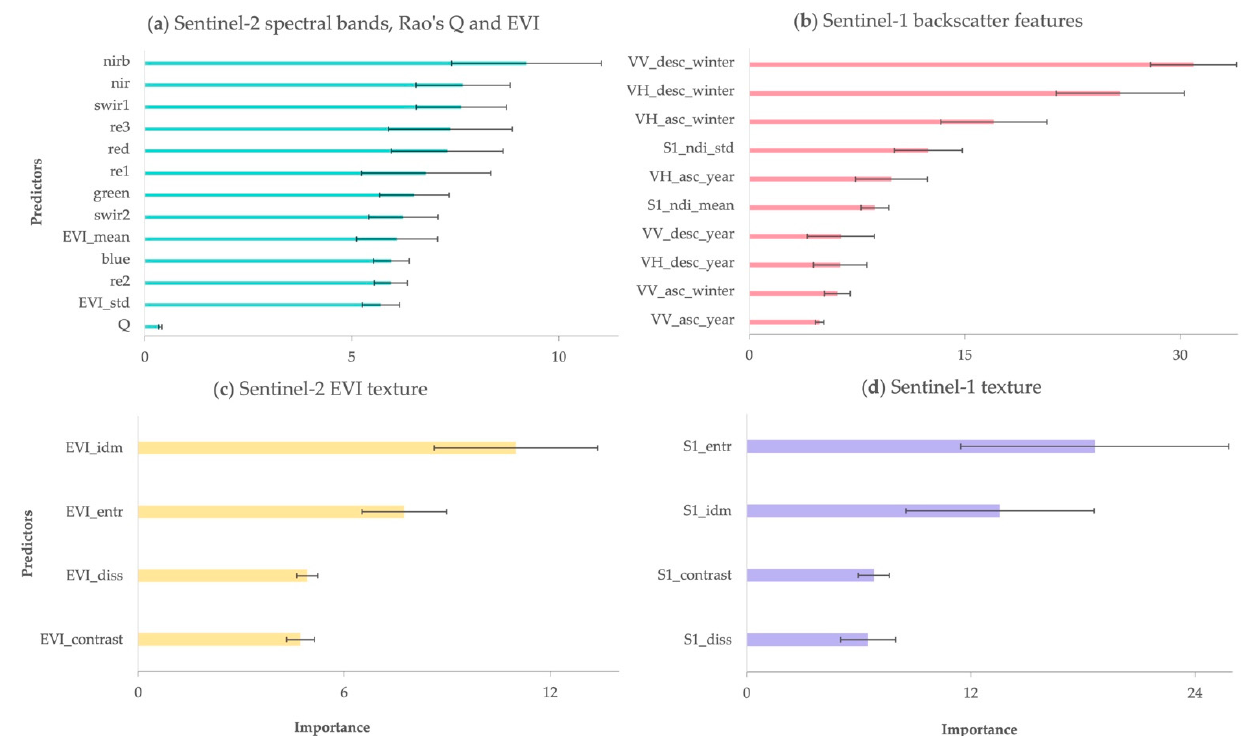
Table 5. Moran’s I result for tree species diversity across the three exploratories. For z-score values between ± 1.65 random distribution of samples can be assumed.